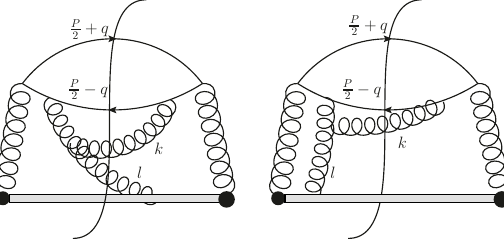
Figure 3 . Typical Feynman diagrams with gluon eikonal vertex for g → Q ¯ Q ( 3 P [1] diagrams can be obtained by permuting the heavy quark and anti-quark. The real and virtual diagrams can be obtained by cutting at different positions.